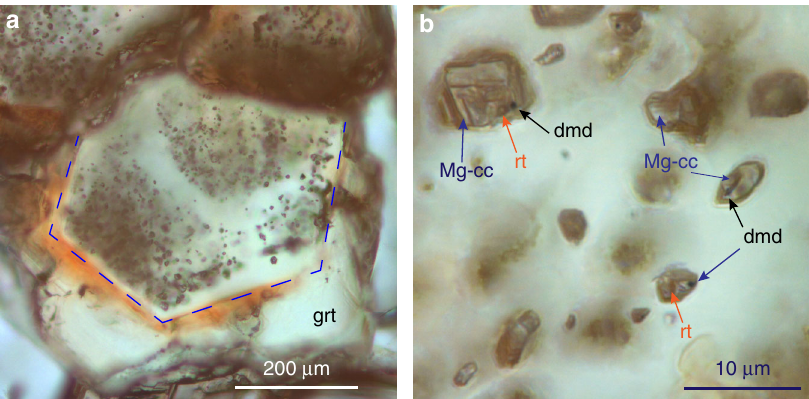
Fig. 1 Photomicrographs of diamond-bearing fl uid inclusions in garnetites from Lago di Cignana (W Alps). a Distribution of fl uid inclusions in garnet cores (grt; blue dotted line). b Aqueous fl uid inclusions containing diamond (dmd), Mg-calcite (Mg-cc), and rutile (rt);